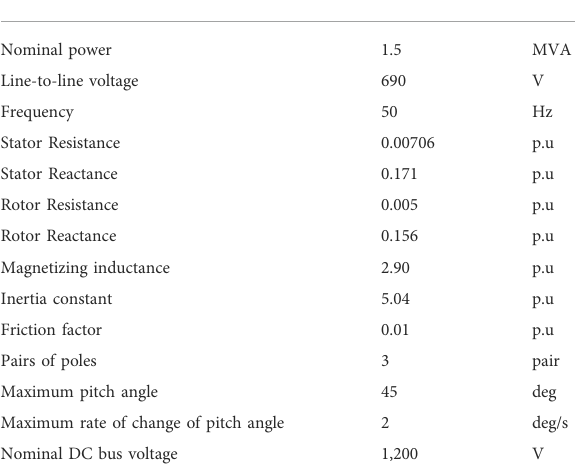
TABLE 1 Parameters of DFIG.